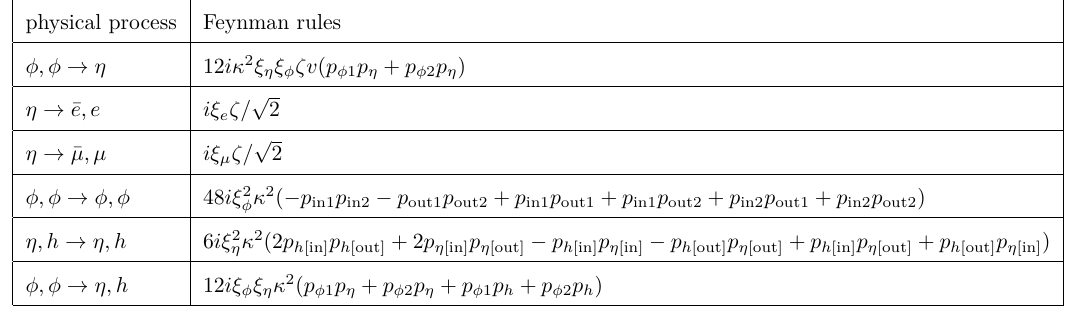
Table 1 . Feynman rules in the Einstein